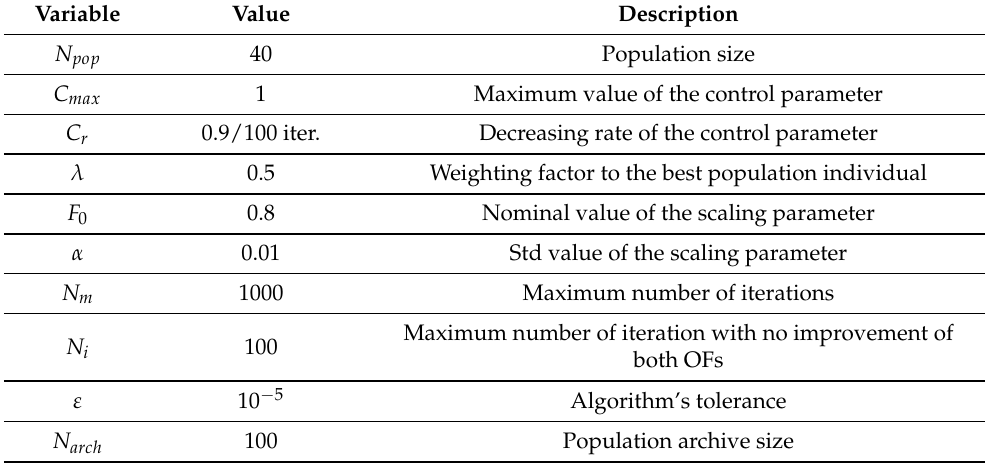
Table 1. DE parameters.